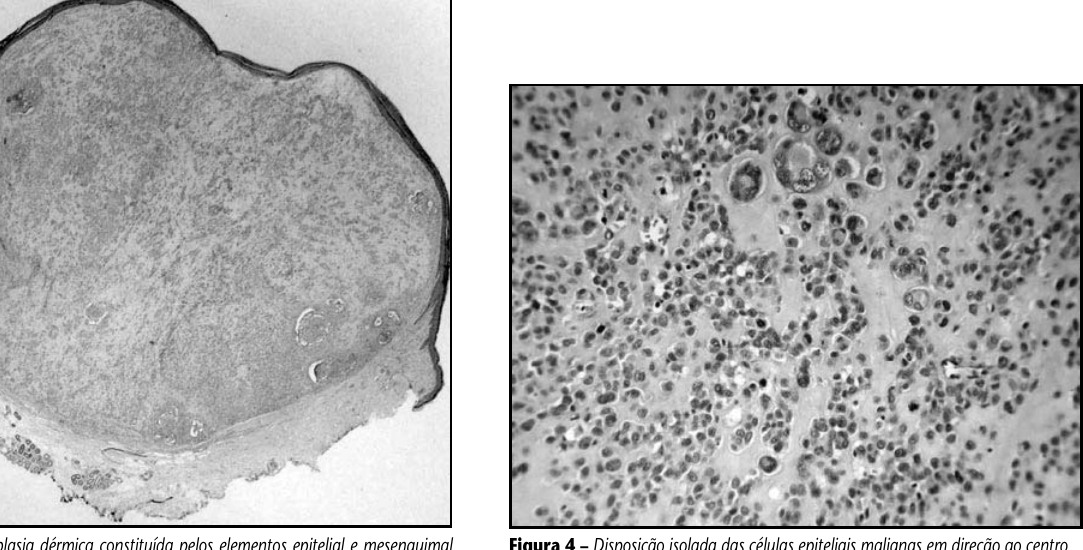
Figura 4 – Disposição isolada das células epiteliais malignas em direção ao centro da lesão (H&E,